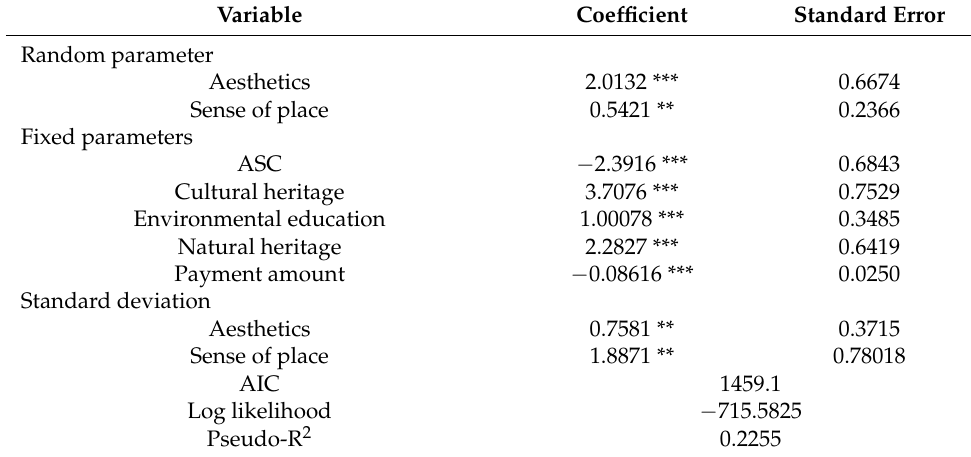
Table 6. Regression results of the random parameter logit